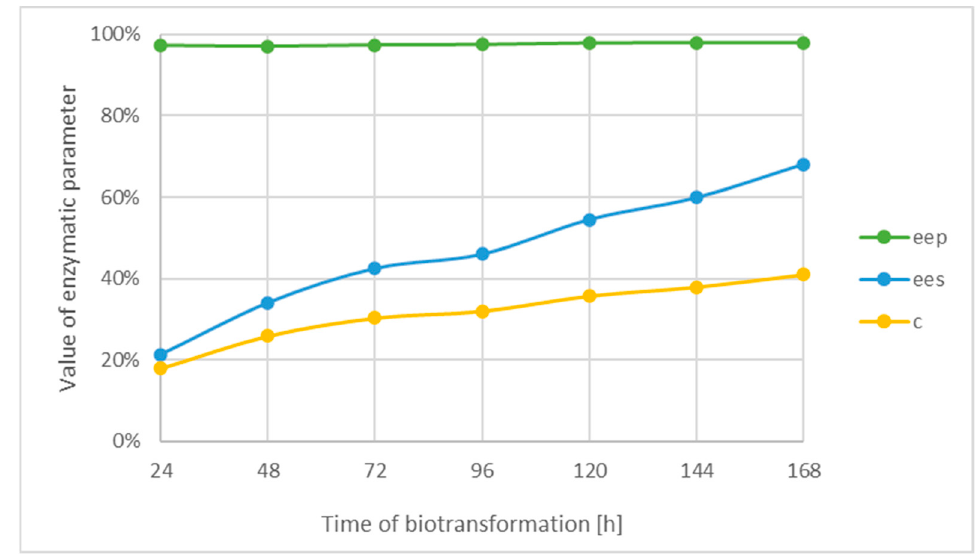
Figure 4. Effect of reaction time on the enzymatic parameters of the performed kinetic resolution of ( R , S )-1-phenylethanol in the two-phase catalytic system consisting of [EMIM][BF 4 ] and n -heptane as well as lipase from Burkholderia cepacia including values of both enantiomeric excesses of substrate (ee s ) and product (ee p ) as well as conversion (c).